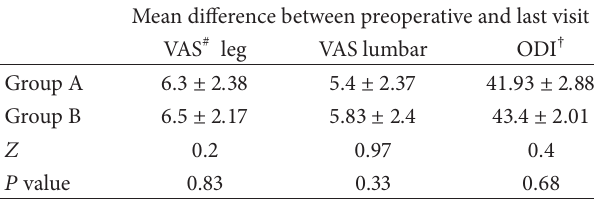
Table 3: Comparison between the groups in terms of pain and disability